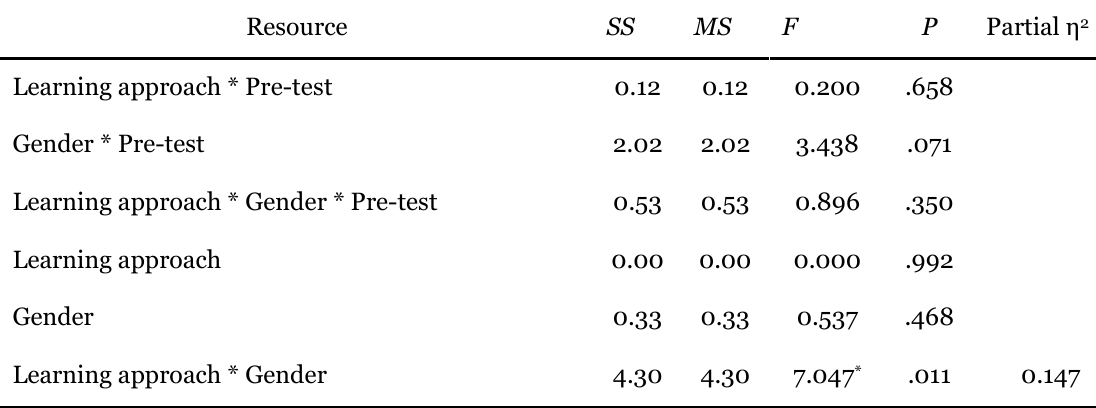
Two-Way ANCOVA Tests of Between-Subjects Effects on Computational Thinking Concepts Resource